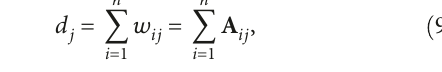
is computed using a prede fi ned σ (4). All the individual kernel matrices Ω l gs is computed. This procedure is repeated for a range of σ values. The σ value C